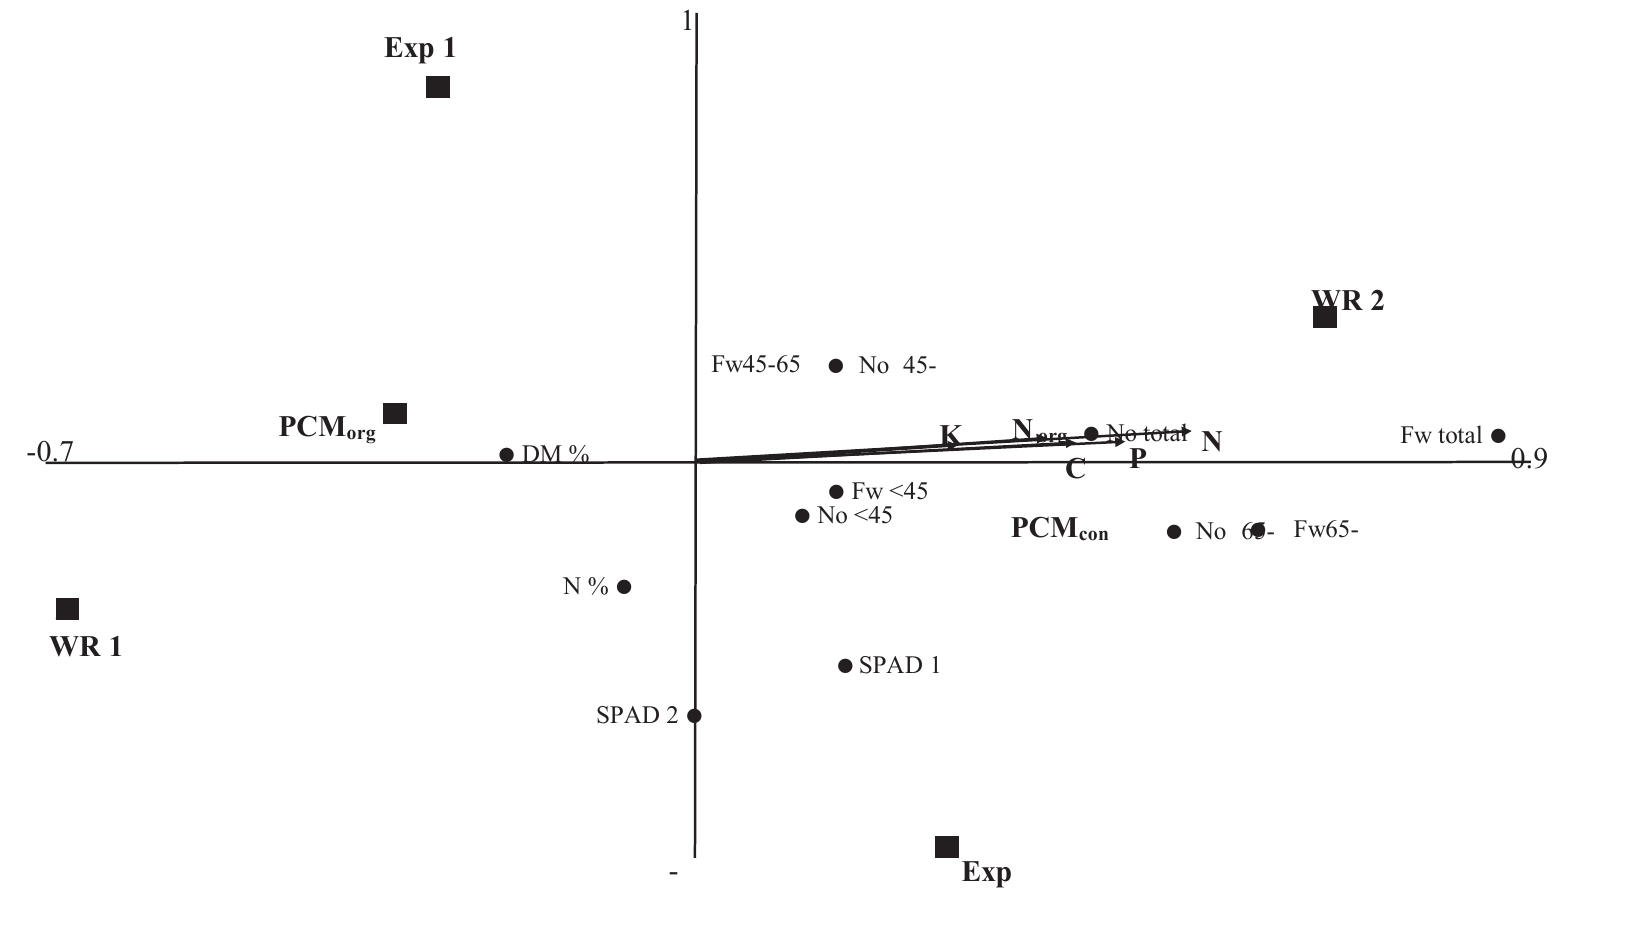
, PCM ), restricted and optimized watering regime org con ], available org